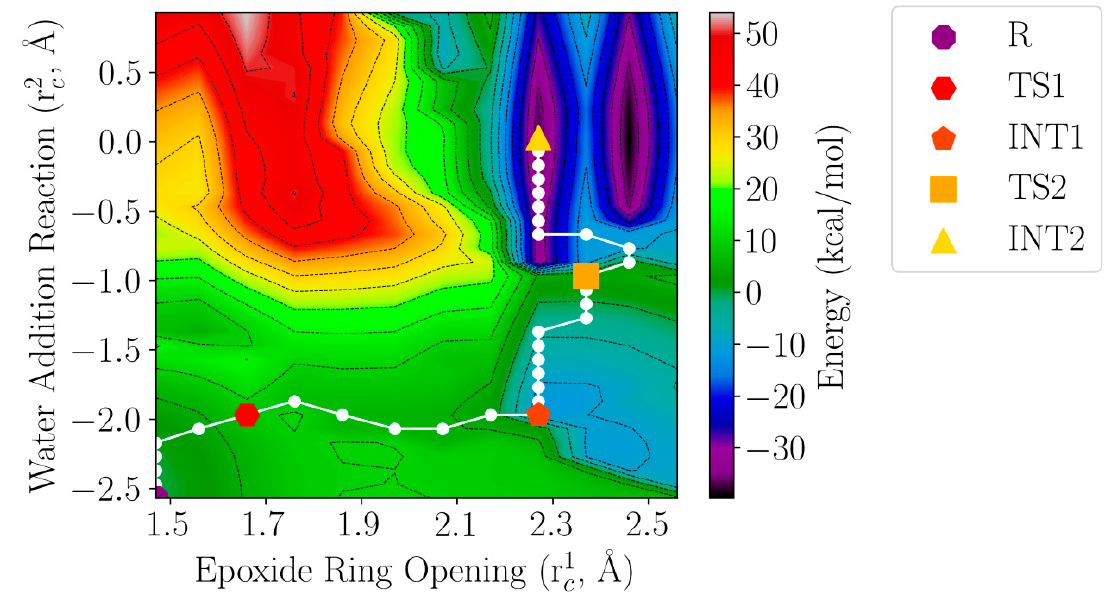
Figure 9. Two-dimensional potential energy surface as a function of the epoxide ring opening and water addition reaction coordinates defined in the text. Isoenergetic lines correspond to intervals of 5 kcal/mol.